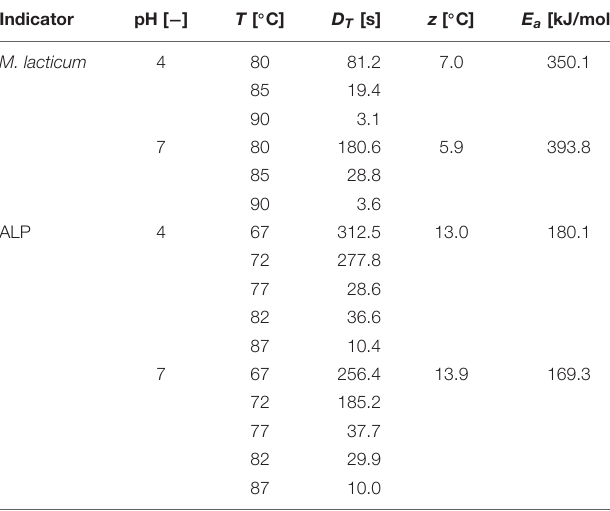
TABLE 4 | Thermal inactivation data of M. lacticum and ALP.